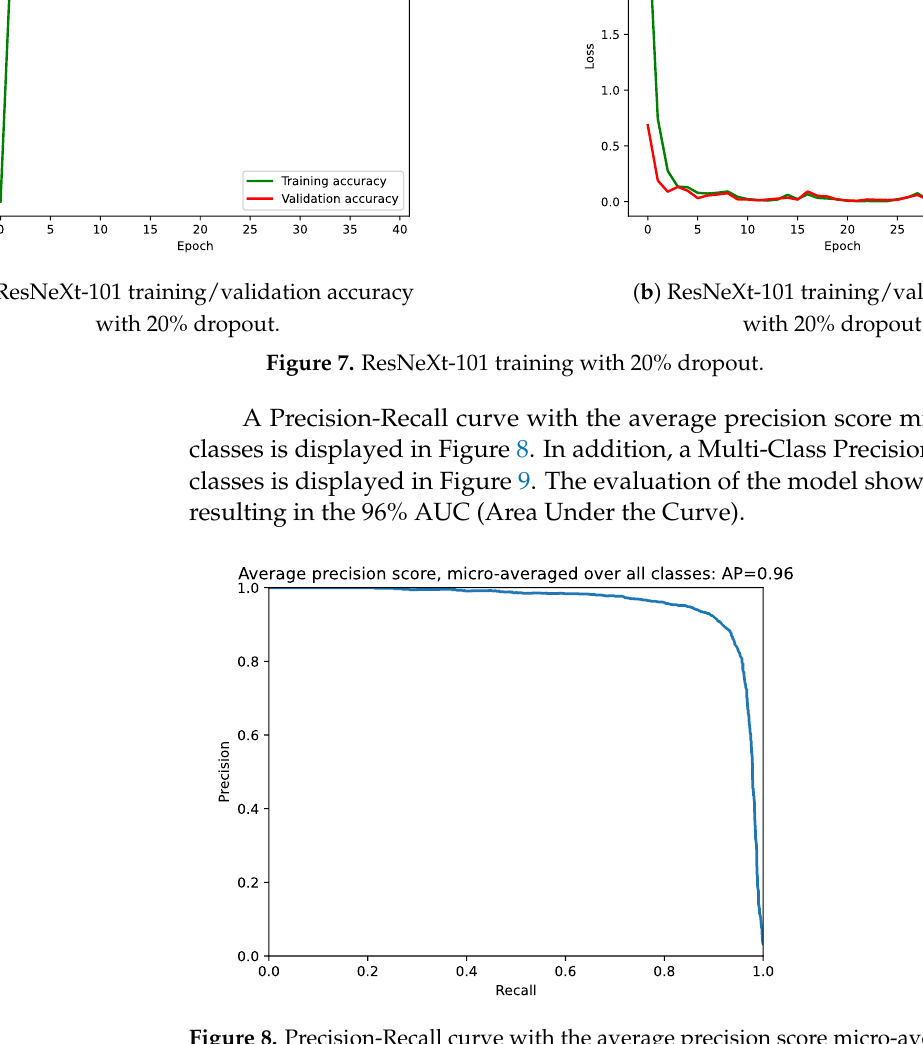
Figure 8. Precision-Recall curve with the average precision score micro-averaged over all